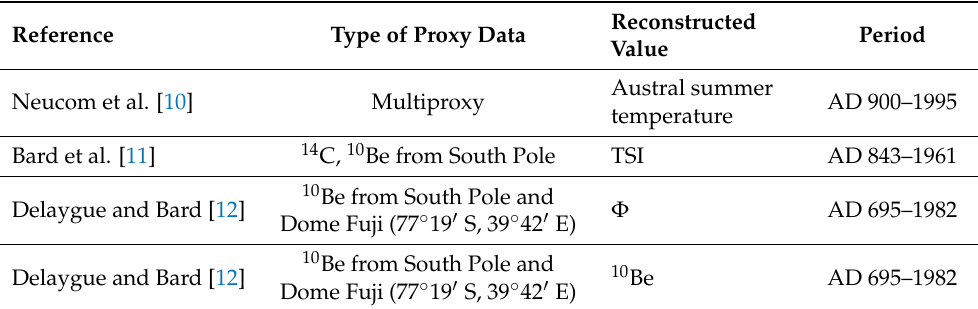
Figure 1. ( A )—summer temperature in SSA [10]; ( B )—concentration of 10 Be in Central Antarctica relative to the 843-1876 AD average [12]; ( C )—solar modulation parameter [12]; ( D )—total solar irradiance [11]. Table 1. Solar and temperature